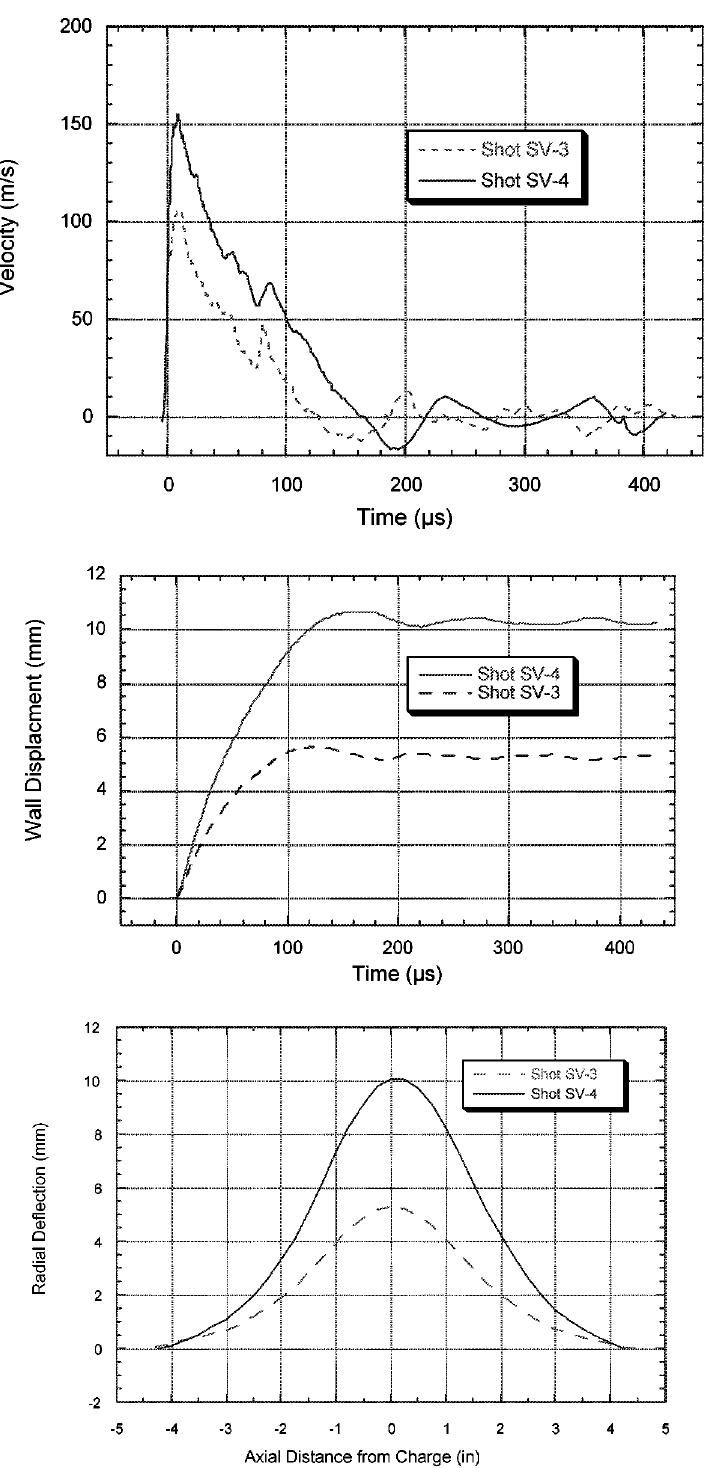
Fig. 5. Outside wall measurements from detonating a 5.7 g charge (Shot SV-4) versus a 3.0 g charge (Shot SV-3). (a)–(b) Dynamic responses at same tube height as center of charge; (c) Permanent deformation along 0 (cid:14)